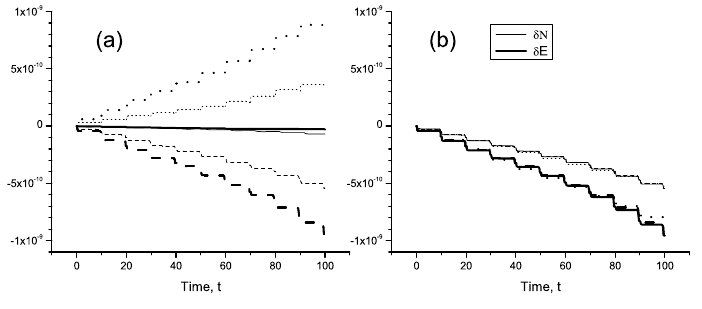
Figure 3. The dependence of relative deviations of invariants, δ N , and δ E on time at different τ and h . (a) h =1/64, (b) τ